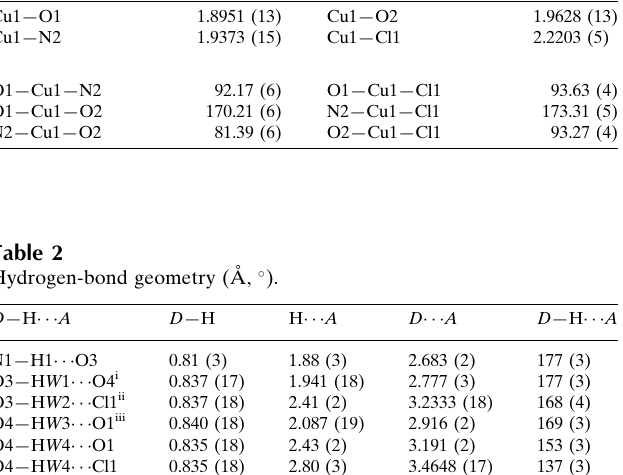
Selected geometric parameters (A˚ , (cid:2) ).